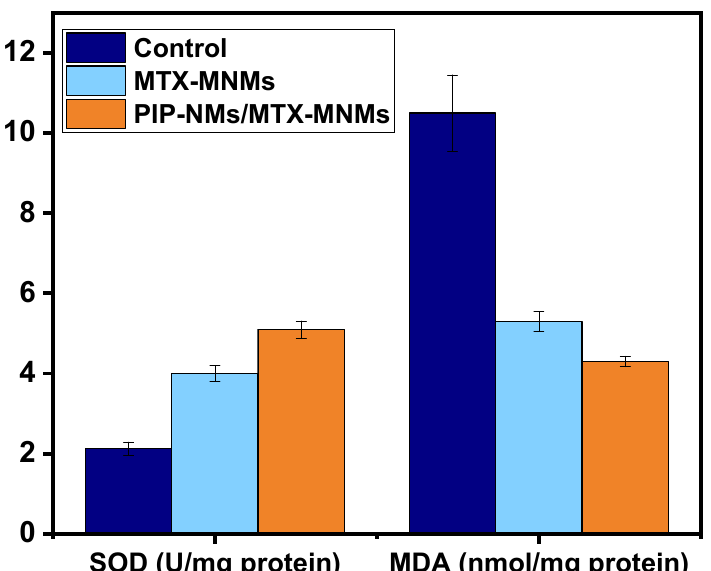
Figure 9. Superoxide dismutase (SOD) levels (U/mg protein) and malondialdehyde levels (nmol/mg protein) in mice treated with MTX-MNMs and PIP-NMs/MTX-MNMs-treated groups relative to the control mice. Data represented as mean ± SD ( n = 7).